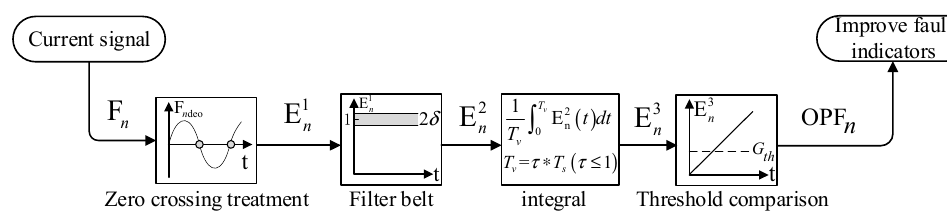
Figure 3. Fault index optimization process of disconnected phase.